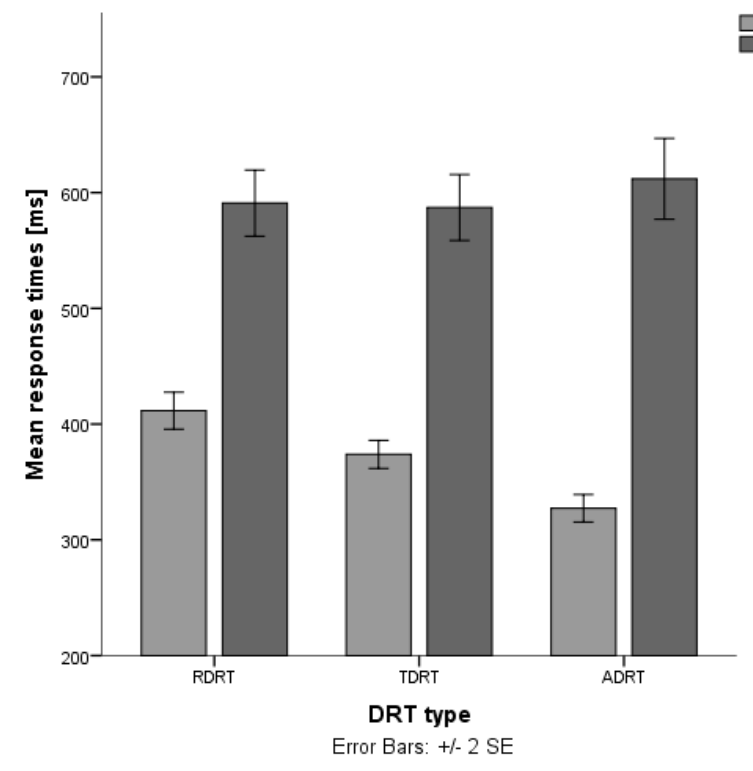
Figure 6. Response times for remote visual DRT (RDRT), tactile DRT (TDRT) and auditory DRT (ADRT) for trials without and with a cognitive task (auditory-vocal n-back task) [10].